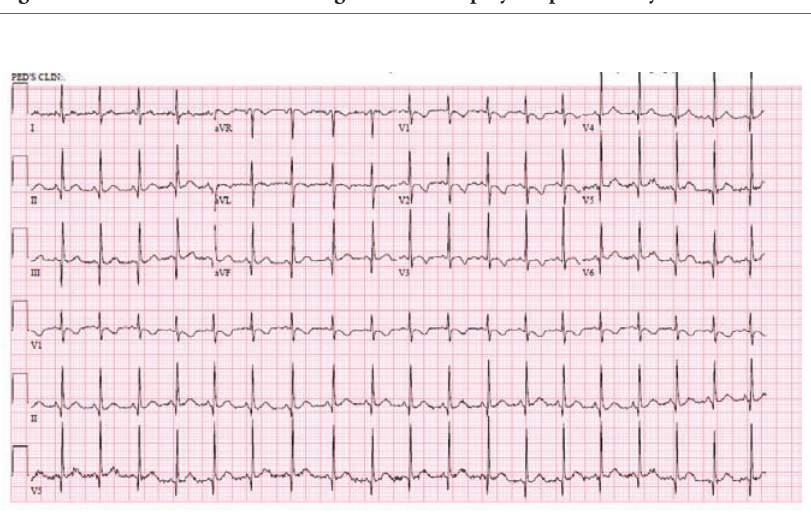
Figure 2. Patient’s normal electrocardiogram even when leads V1 and V2 were placed higher in the